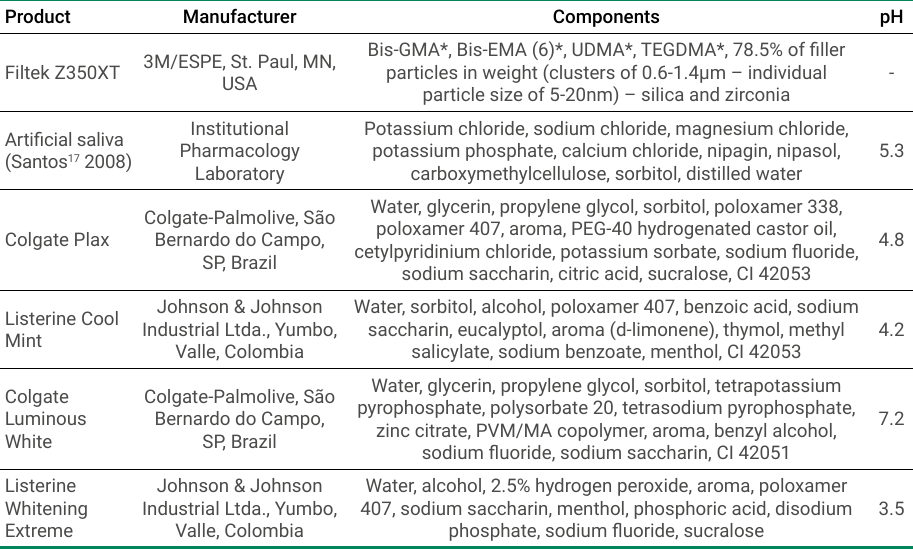
Table 1. Materials used in the